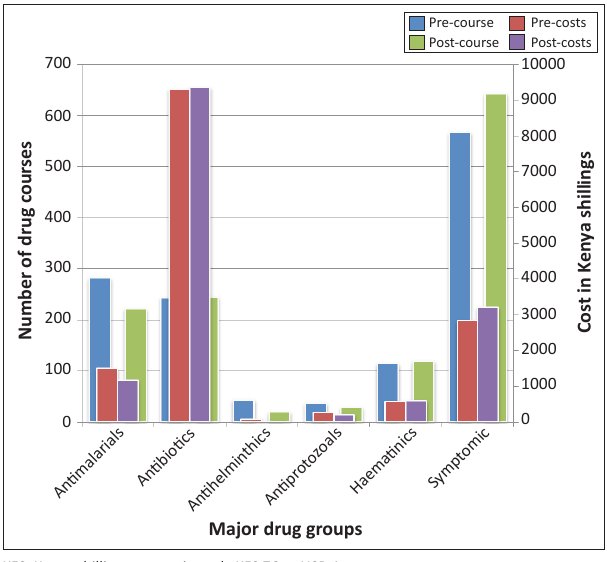
FIGURE 2: Number of drug courses prescribed and costs before and after laboratory testing.